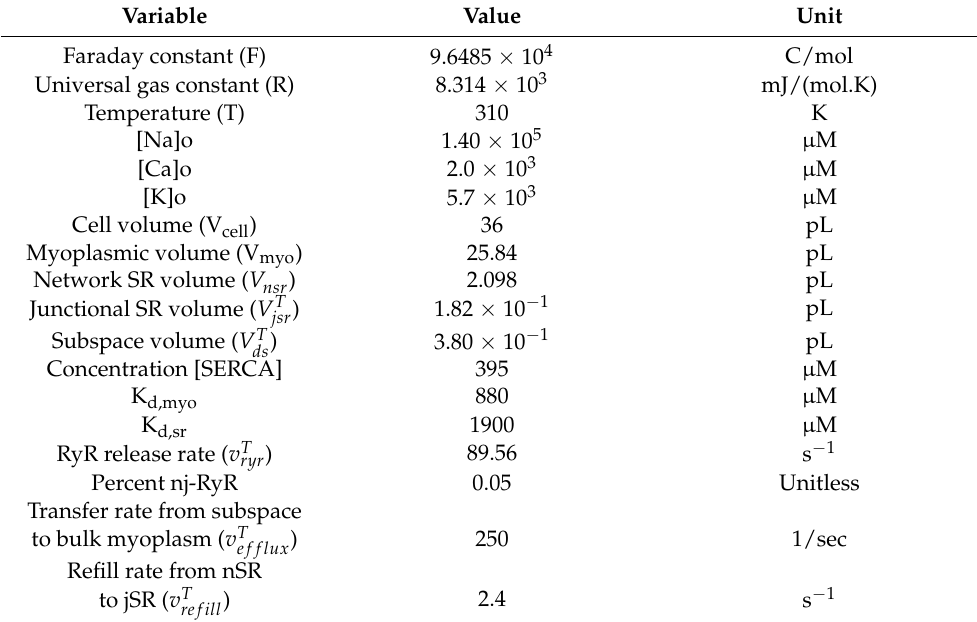
Table A2. Parameters used in the